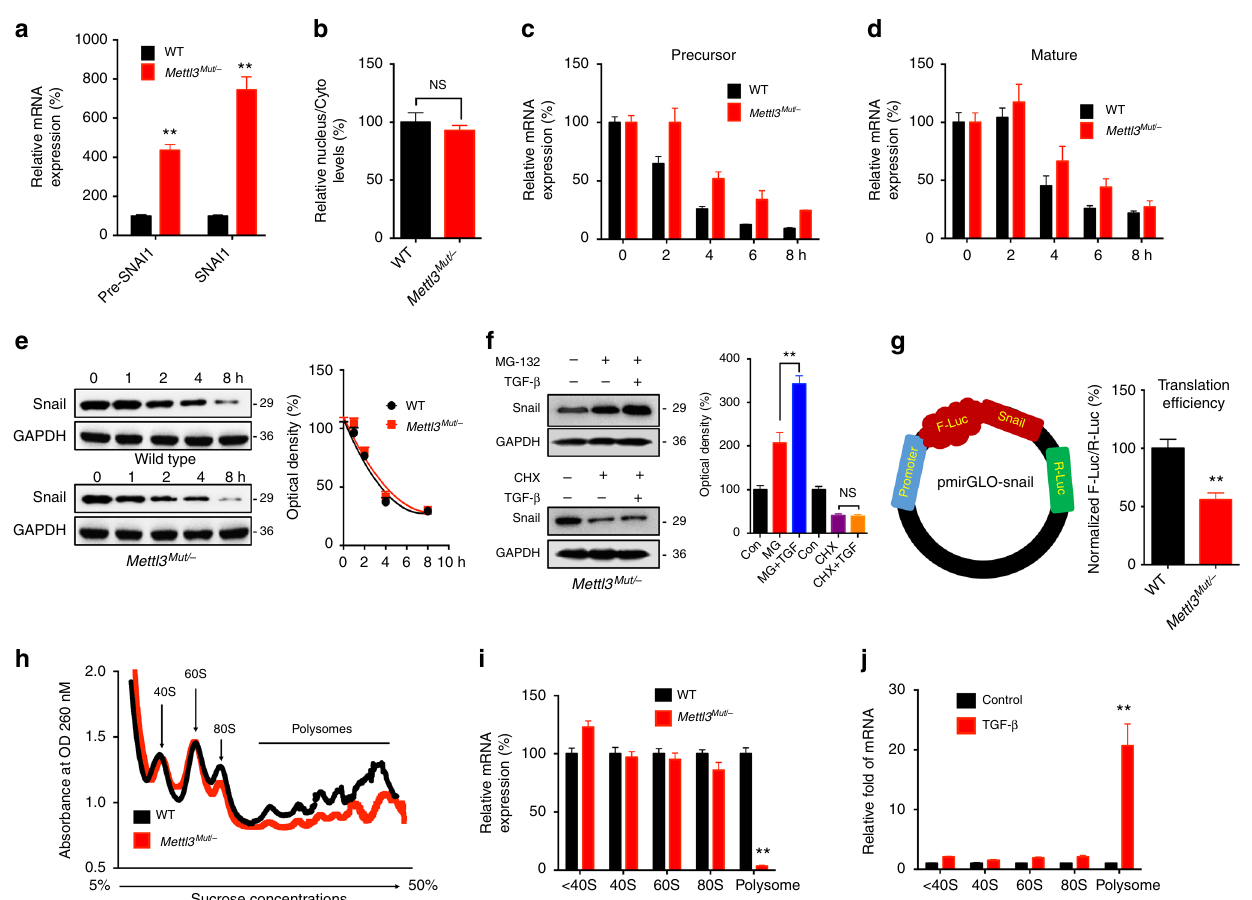
Fig. 4 m 6 A triggers translation of Snail mRNA in cancer cells. a Precursor and mature mRNA of SNAI1 in wild-type (WT) and Mettl3 Mut/ − cells. b The relative levels of the nuclear versus cytoplasmic SNAI1 mRNA in wild-type (WT) or Mettl3 Mut/ − cells. c, d Wild-type (WT) or Mettl3 Mut/ − cells were pretreated with Act-D for 90 min, then precursor ( c ) or mature ( d ) SNAI1 mRNA were analyzed at indicated times. e Wild-type (WT) or Mettl3 Mut/ − cells were treated with CHX for the indicated times, and protein expression of Snail was analyzed by western blot analysis (left) and quantitatively analyzed (right); f Mettl3 Mut/ − cells were pretreated with CHX or MG-132 for 6 h and then further treated with or without 10 ng/ml TGF- β for 48 h, the expression of Snail was detected by western blot analysis (left) and quantitatively analyzed (right). g Wild-type (WT) or Mettl3 Mut/ − cells were transfected with pmirGLO-Snail reporter for 24 h, and the translation ef fi ciency of Snail is de fi ned as the quotient of reporter protein production (F-luc/R-luc) divided by mRNA abundance 7 . h Polysome pro fi ling of wild-type (WT) or Mettl3 Mut/ − HeLa cells were analyzed. i Analysis of Snail mRNA in non-ribosome portion (< 40S), 40S, 60S, 80S, and polysome for the Mettl3 Mut/ − cells compared to control cells. j Analysis of Snail mRNA in non-ribosome portion (< 40S), 40S, 60S, 80S, and polysome for EMT undergoing HeLa cells compared with control cells. Data are presented as means ± SD from three independent experiments. * p < 0.05, NS, no signi fi cant, by Student ’ s t